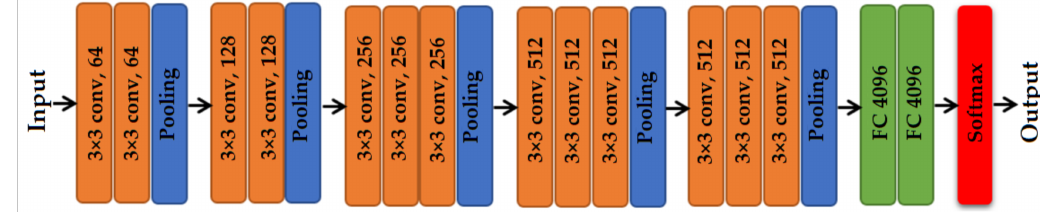
Figure 3. VGG-16 model